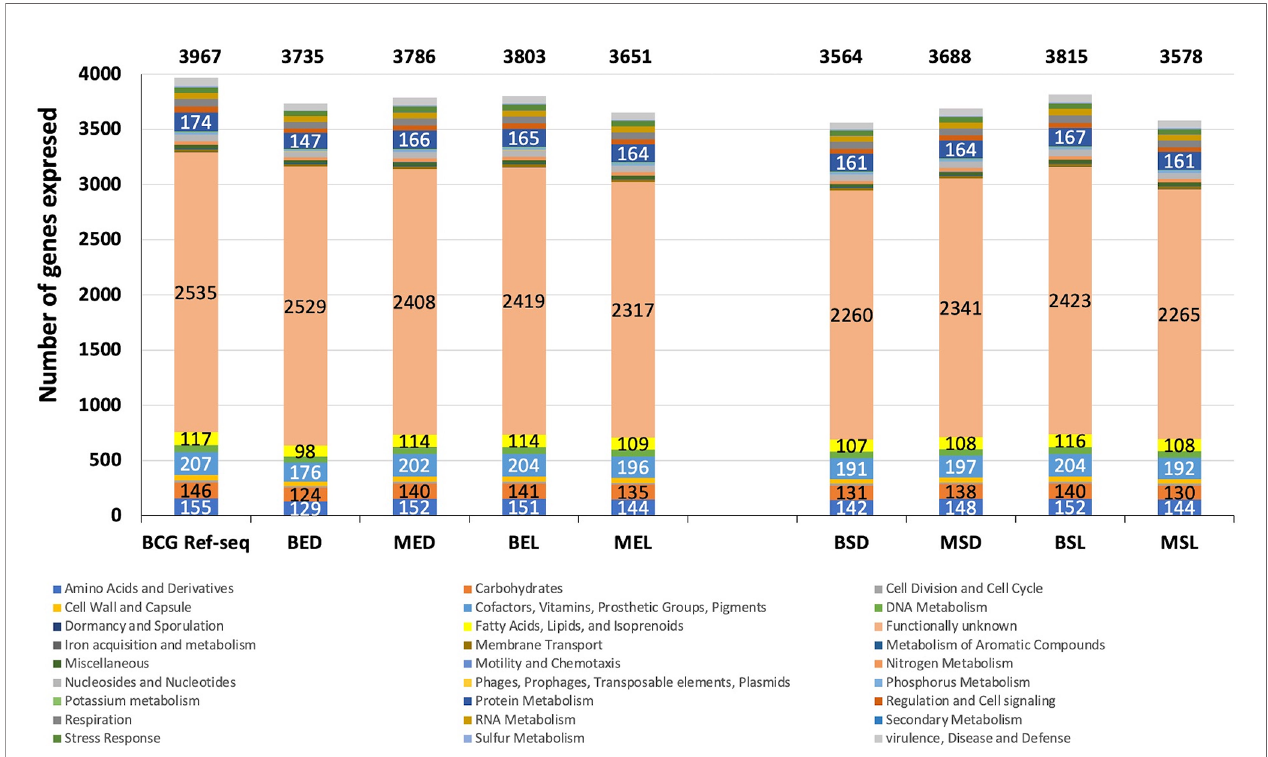
FIGURE 1 | Global gene expression of wtBCG and mtBCG under different environmental conditions. Gene clustering by functional categories was carried out using the RAST server (http://rast.theseed.org/FIG/rast.cgi) and the reference genome of M. bovis BCG available in the NCBI ( NC_008769 ). Six functional categories, ( 1) functionally unknown ORF; 2) cofactors, vitamins, and prosthetic groups; 3) protein metabolism; 4) amino acids and derivatives; 5) carbohydrates; and 6) fatty acids, lipids, and isoprenoids (in almost all cultured conditions), showed changes in the expression of total M. bovis BCG